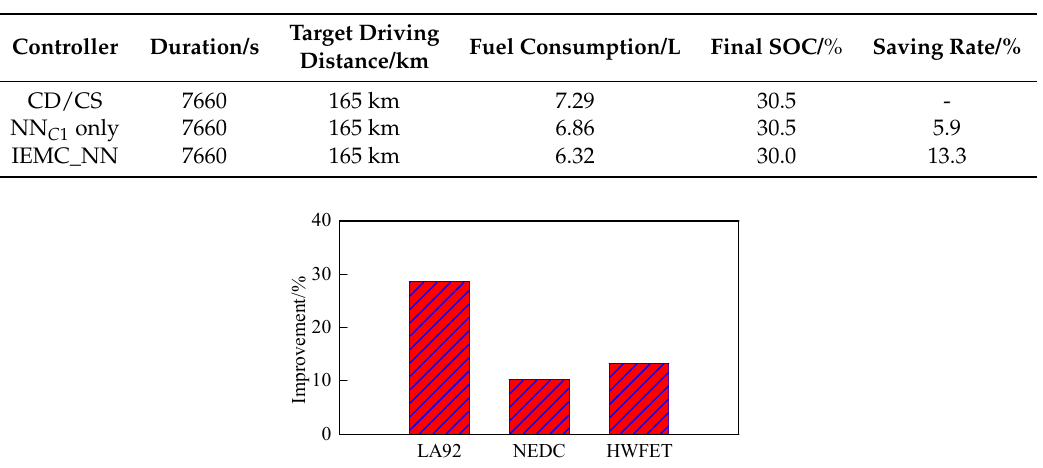
Table 5. Fuel economy comparison when the target driving distance changes during the trip (HWFET cycle).